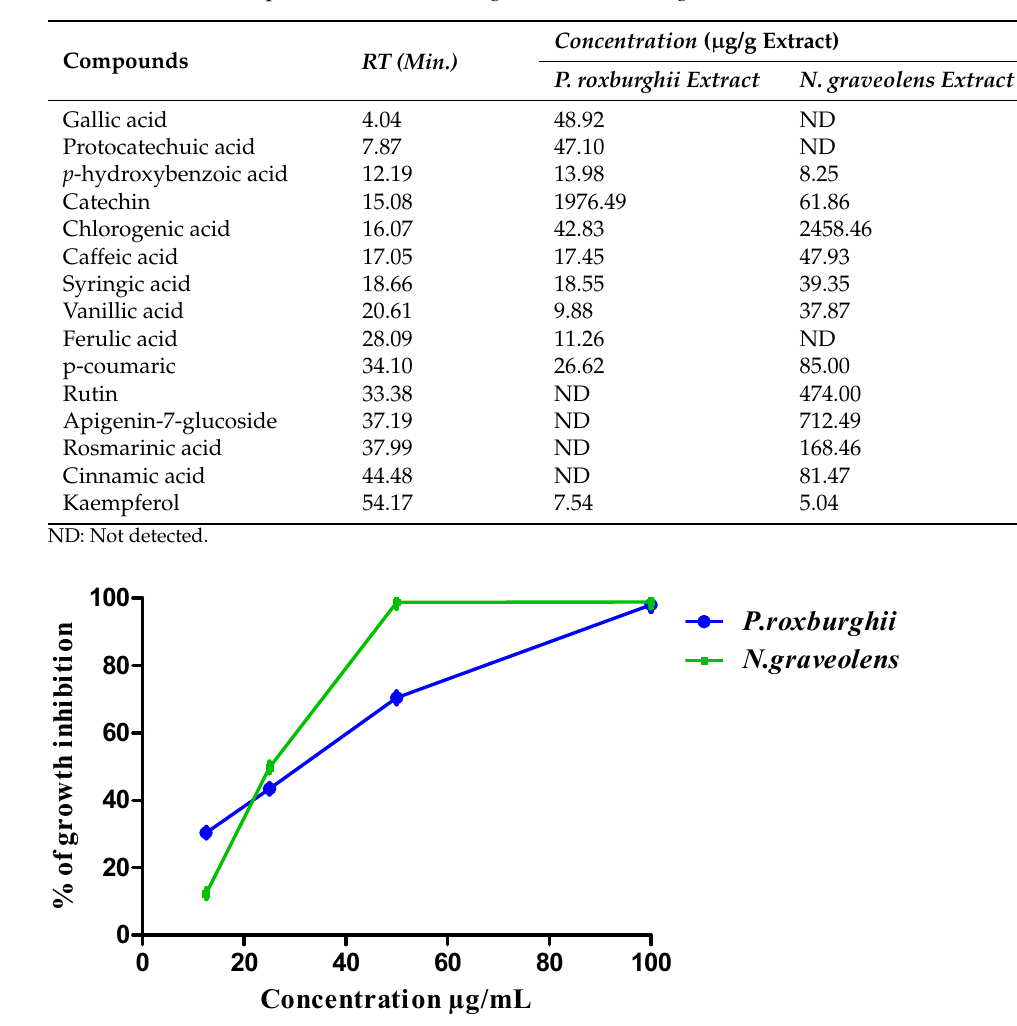
Figure 1. Impact of P. roxburghii and N. graveolens extracts at different concentrations on a human colon cancer cell line (HCT ‐ 116).